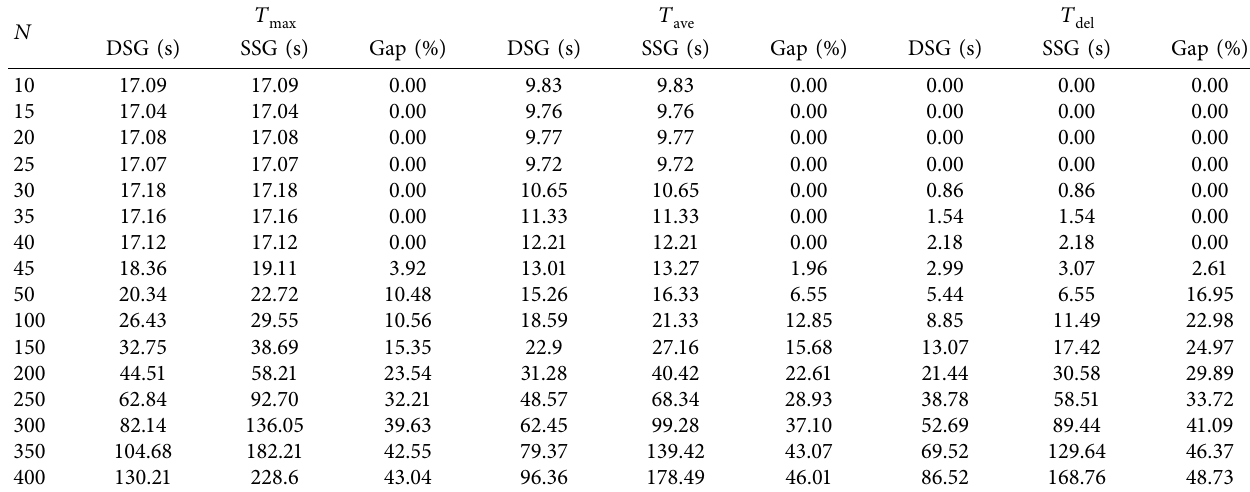
Table 2: : Comparative results with different number of